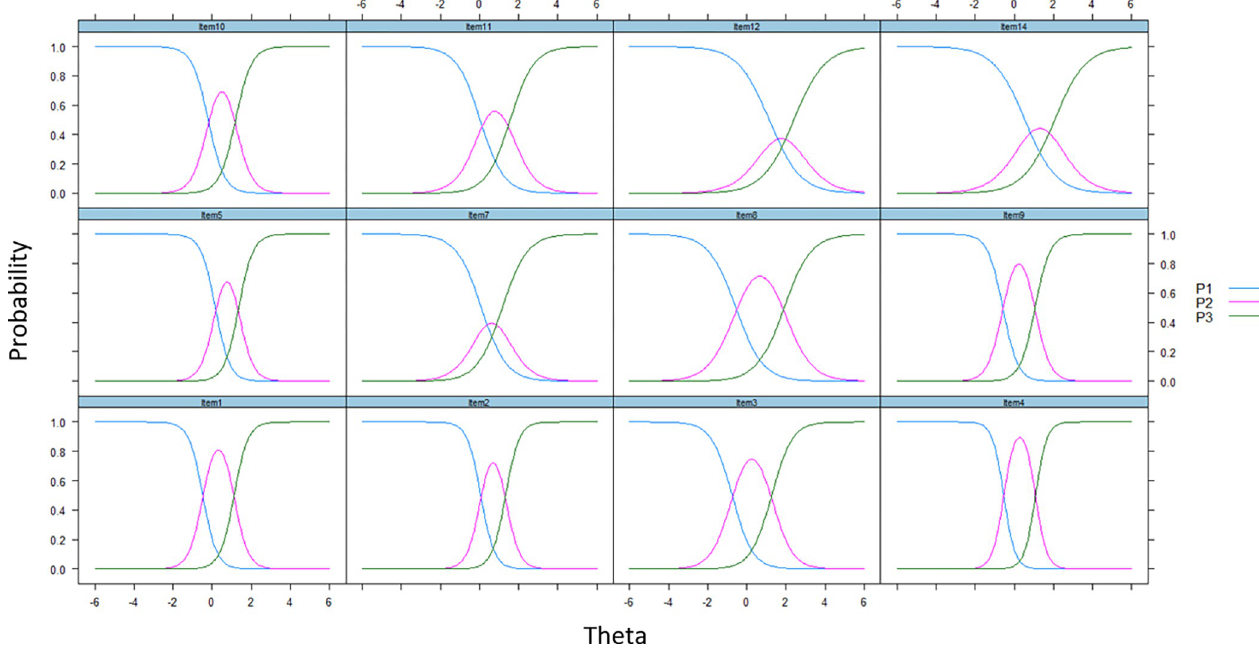
Fig 3. Recoded thresholds for final analysis on 12 items with 3 response categories each displayed as 0-1-1-1-1-1-1-1-1-1-2.